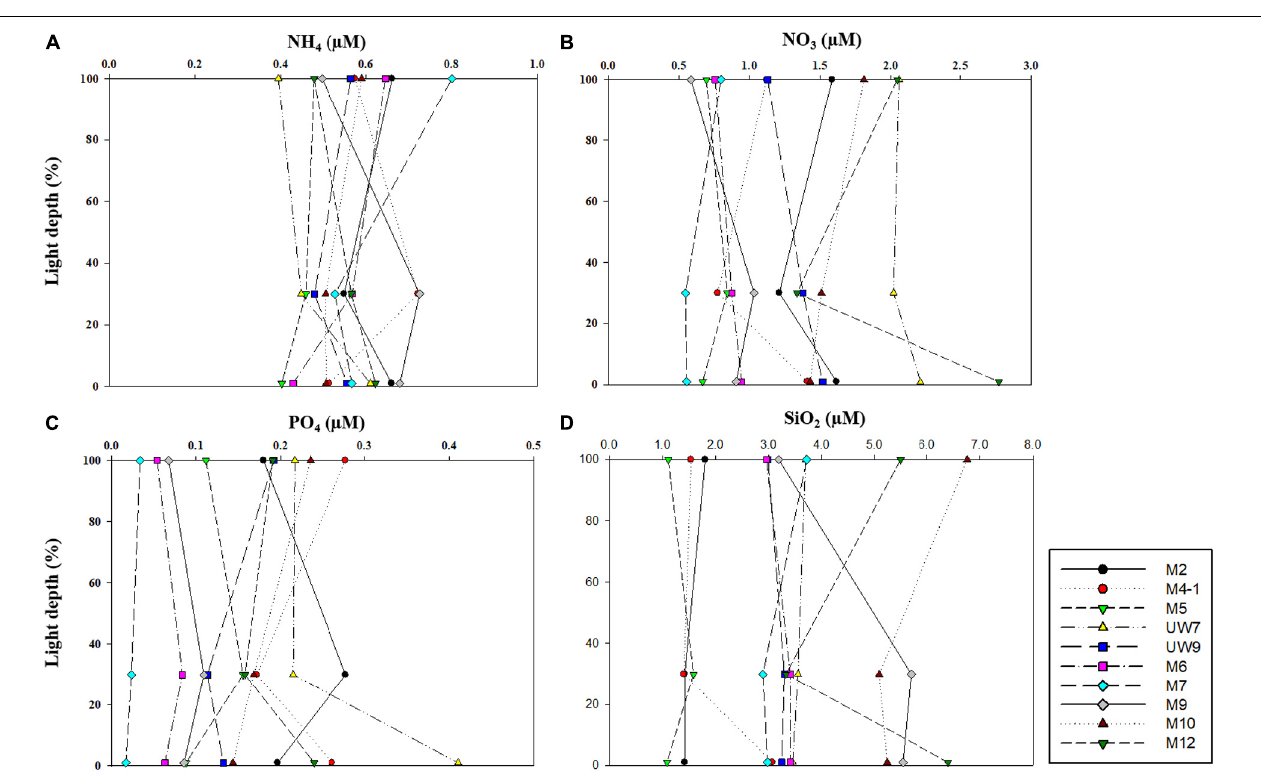
( Figure 5A and Table 1 ). In the UB region, the average values of the concentrations of chl a from small and large phytoplankton integrated over depths with light penetration ranging from 100